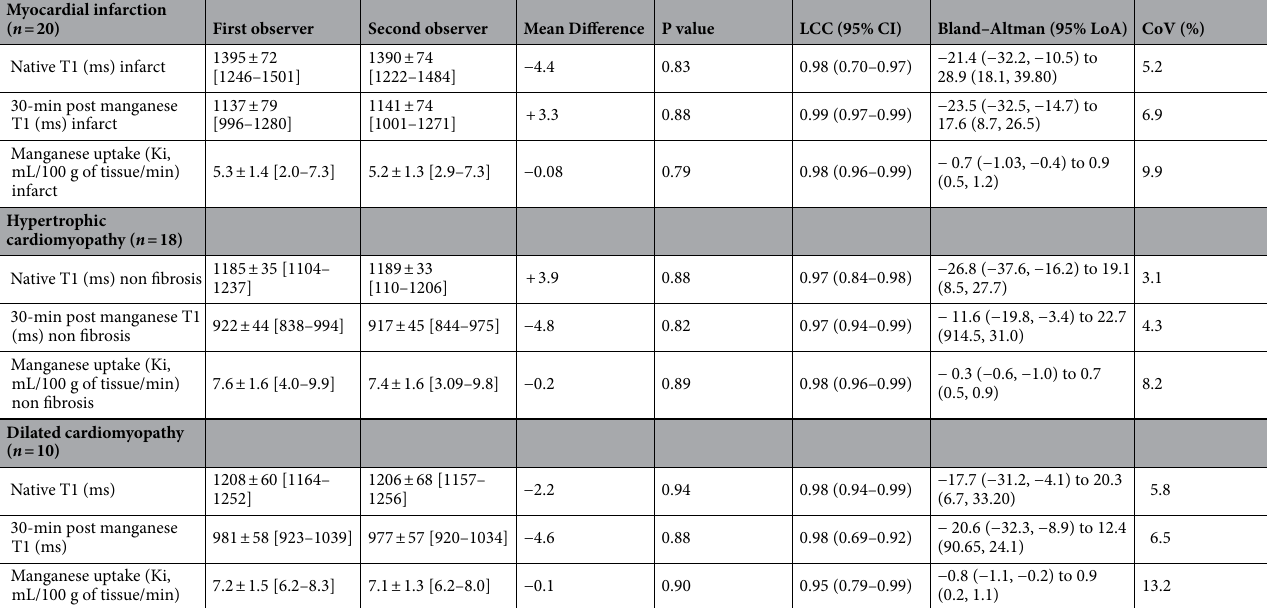
Table 3. Inter-observer repeatability for patients with myocardial infarction (infarct), hypertrophic cardiomyopathy (non-fibrosis) or dilated cardiomyopathy. Mean ± standard deviation [95% confidence interval]. LCC Lin’s concordance correlation, LoA limits of agreement, CoV coefficient of